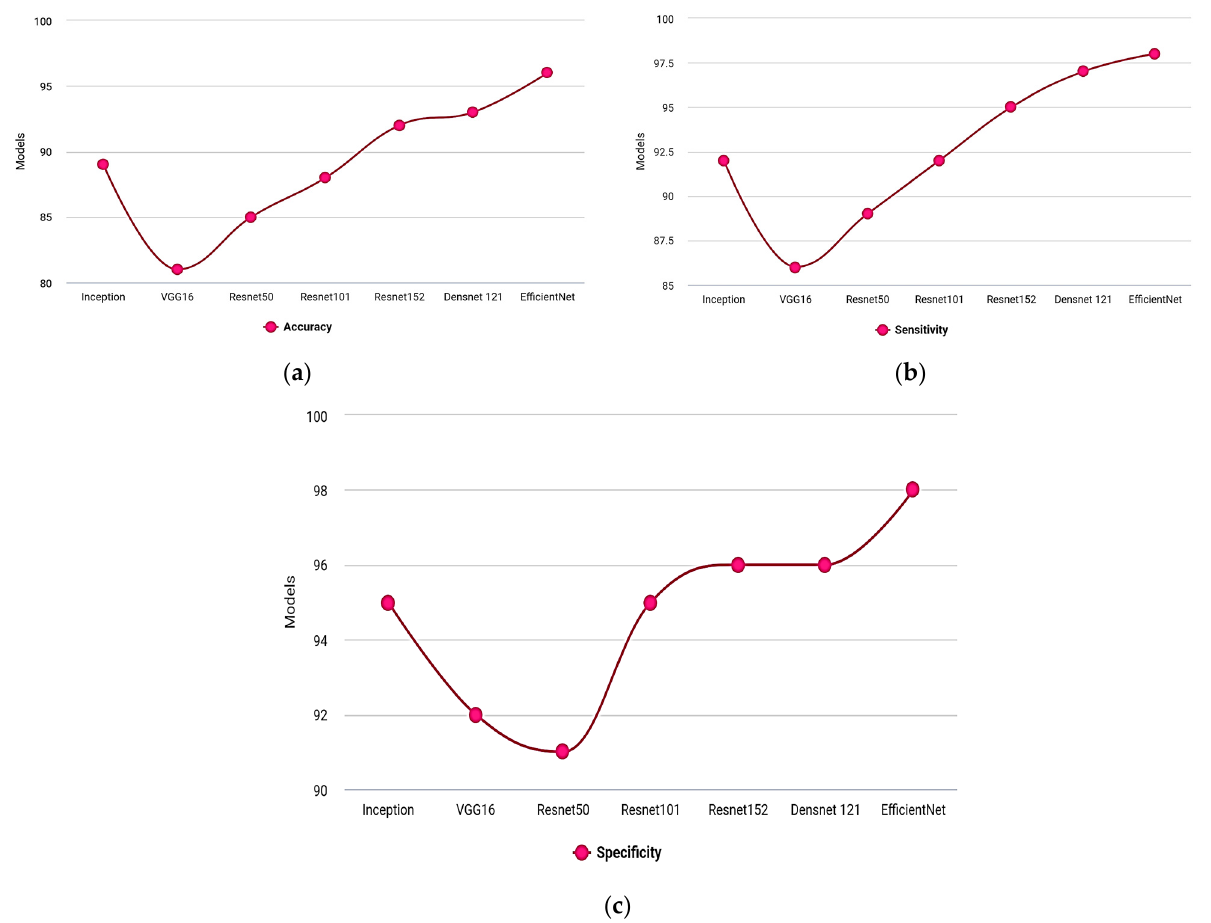
Figure 7. Models vs. ( a ) Accuracy, ( b ) Sensitivity, ( c ) Specificity.